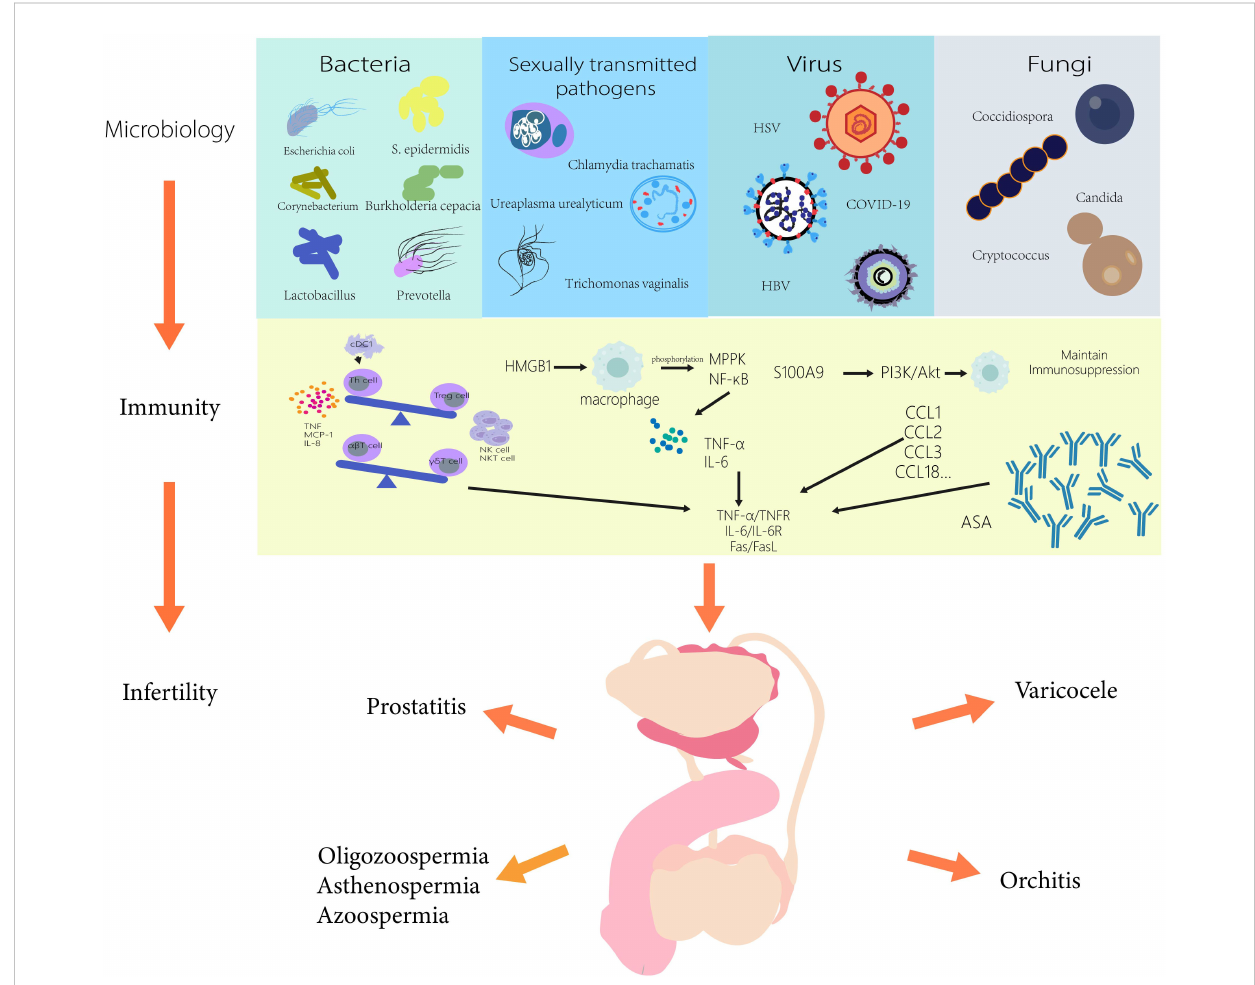
FIGURE 1 Microbiology and immune mechanisms associated with male